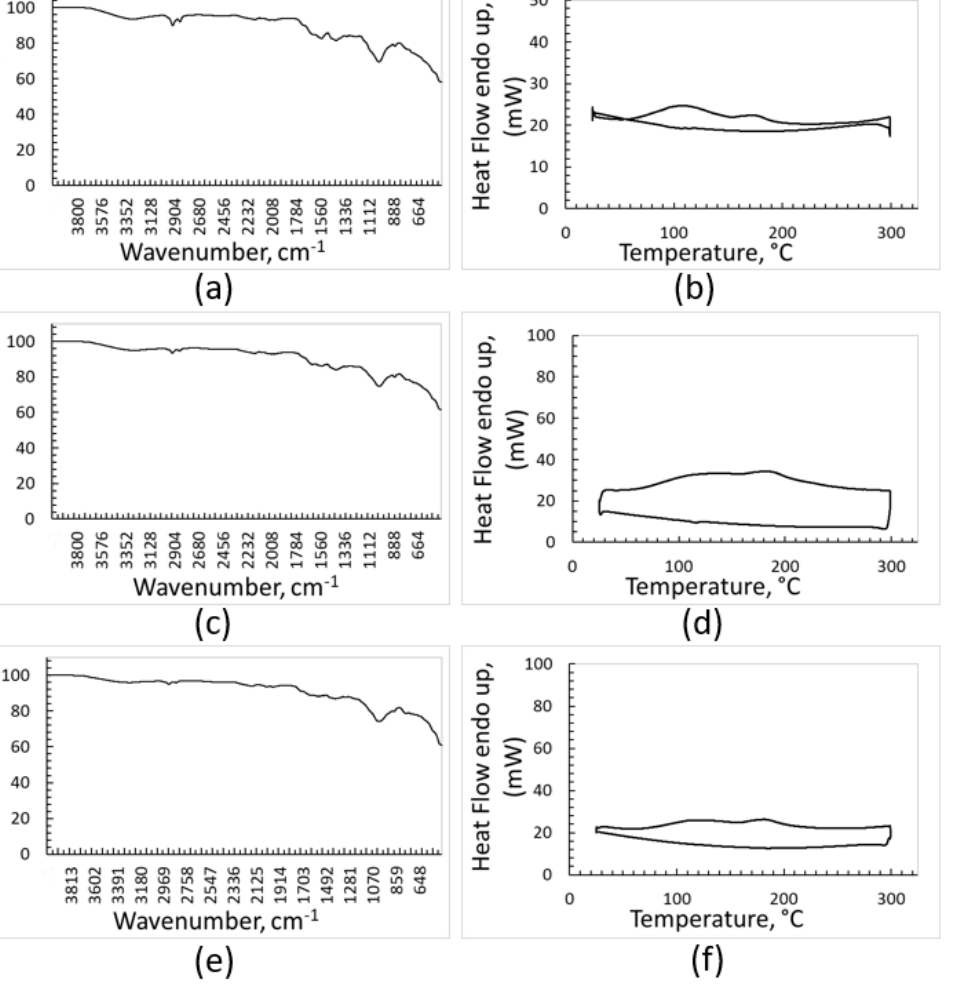
Figure 2. FTIR and DSC analyses of contaminants removed from: PE ( a , b ), PP ( c , d ), PET ( e , f ).